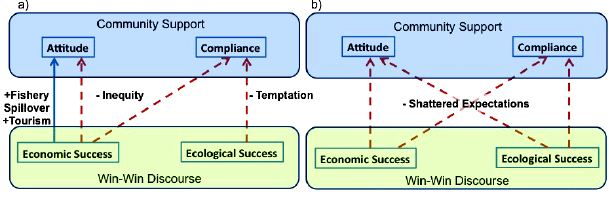
Fig. 6 . MPA success and its effect on community support. (a) A successful MPA. (b) An MPA not achieving its economic and ecological objectives. MPA indicates marine protected